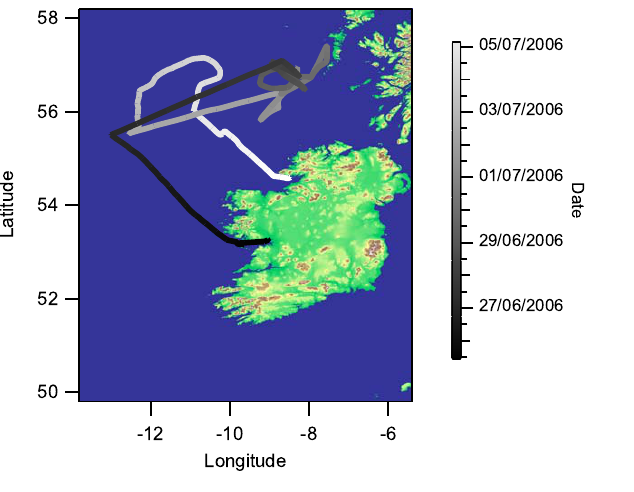
Fig. 10. The Celtic Explorer cruise track between 26th June 2006 and 5th July 2006 during the MAP campaign.